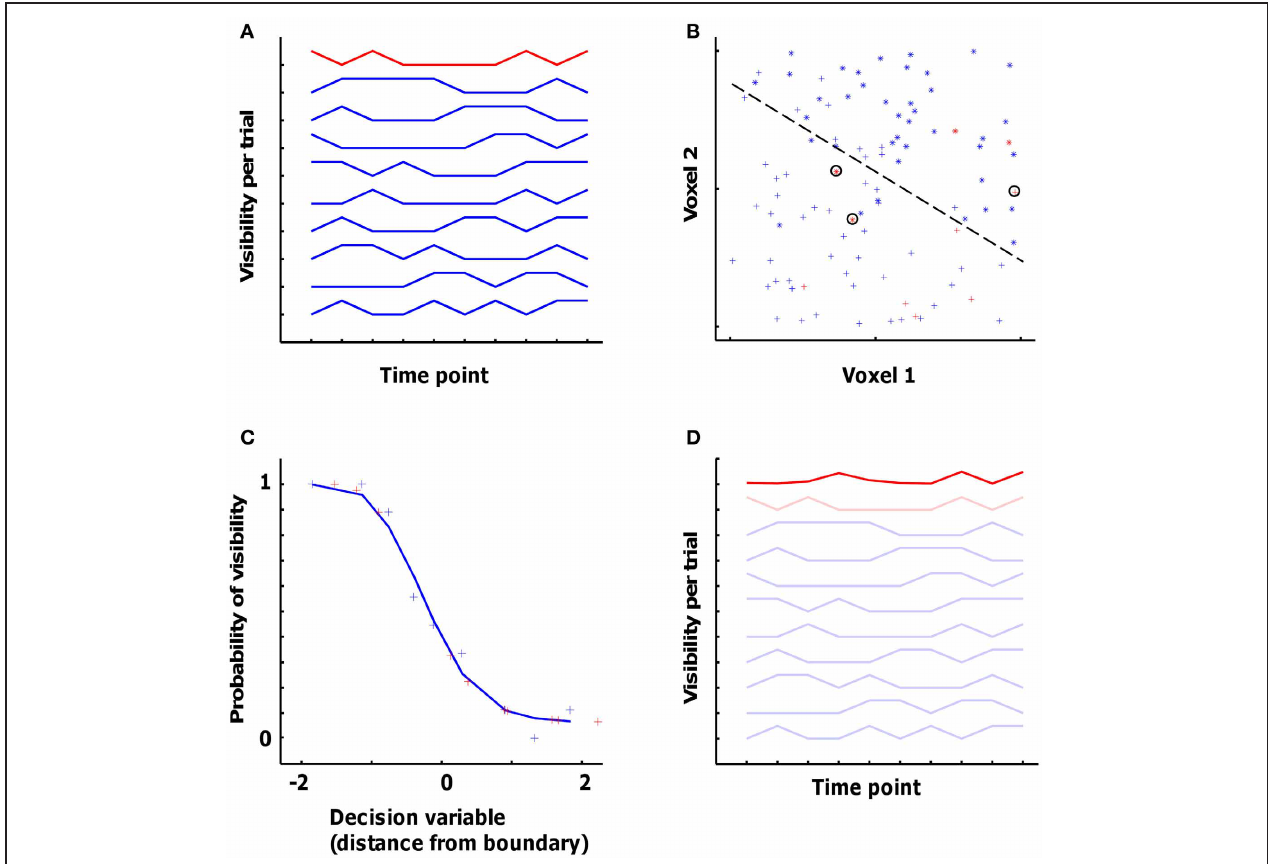
FIGURE 3 | Simulation dataset to illustrate the pattern classification approach applied to the fMRI data. (A) Visibility (0 or 1) for 10 ‘trials’. Nine trials, shown in blue, are used for training the classifier, with one remaining trial (shown in red) left out for cross-validation. (B) The fMRI signal in two simulated voxels at each of the 10 × 10 data points. The 9 × 10 blue data points are involved in training together with the associated visibility label (represented by the ‘ + ’ and ‘ ∗ ’ symbols). The dashed line represents the optimal decision boundary to separate the visible from the non-visible category. The 10 red data points represent the cross-validation data, 3 out of